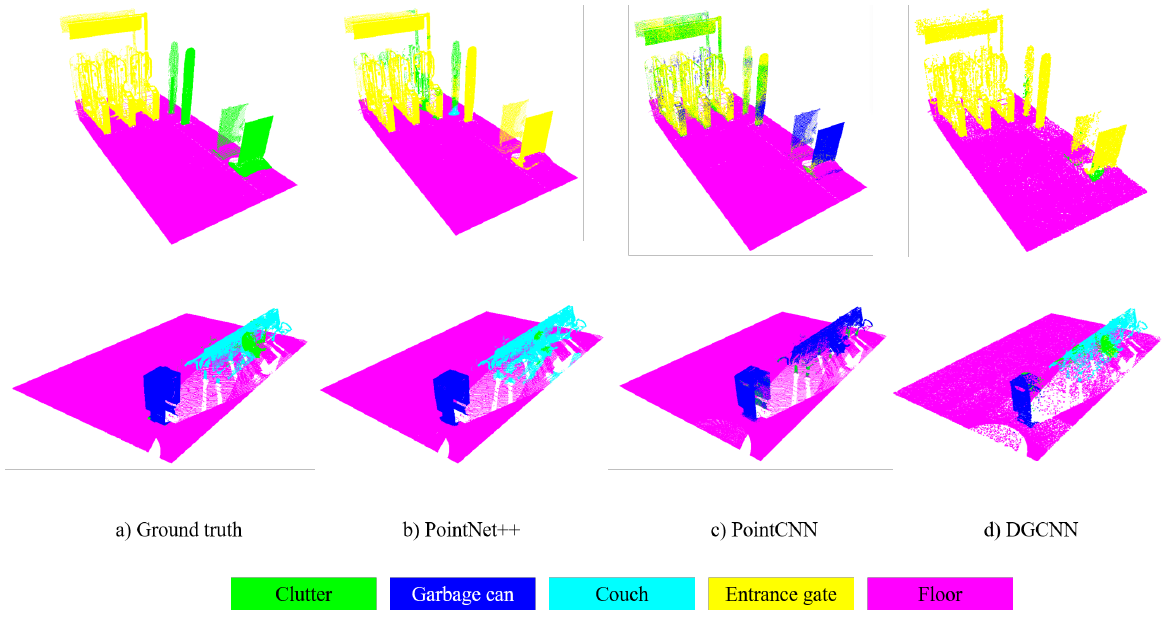
Figure 6. Visualization of each network on the test